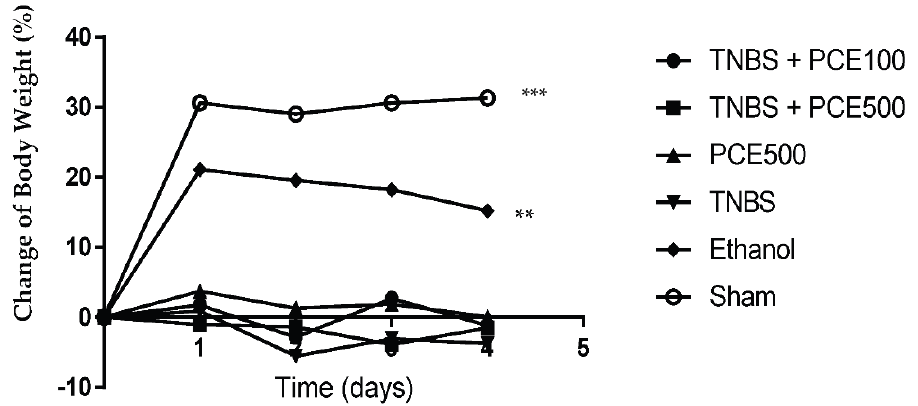
Figure 1. Change of body weight during PCE treatment in the IBD. The results are represented as mean ± SD [ n (TNBS + PCE100) = 10; n (TNBS + PCE500) = 10; n (PCE) = 10; n (TNBS) = 6; n (Ethanol) = 5; n (Sham) = 5; ** p < 0.01; *** p < 0.001 compared with TNBS group, Two ‐ way ANOVA followed by Tukey’s post hoc test]. Abbreviations: IBD, inflammatory bowel disease; PCE, phenolic compounds extract; TNBS, 2,4,6 ‐ Trinitrobenzene sulfonic acid.